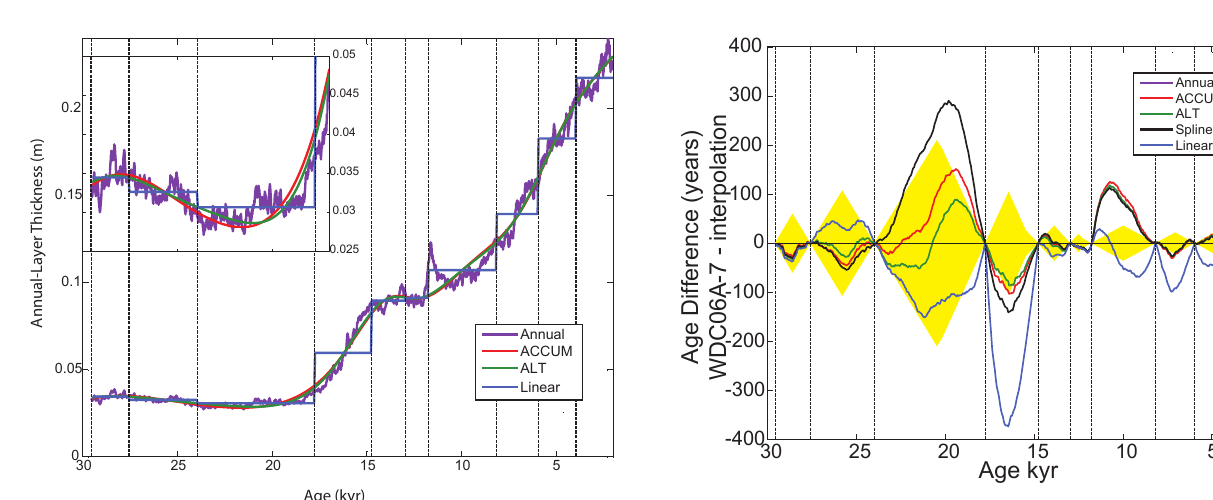
Figure 3. A 100-year running average of annual-layer thicknesses for the WDC06A-7 compared with inferred annual-layer thickness for the different interpolations. Black vertical dashed lines are tie points. Inset in upper left shows detailed view for 29.6 and 17kyr intervals.